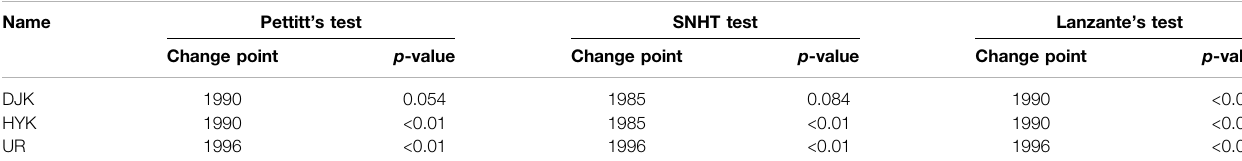
TABLE 3 | Results of Pettitt, SNHT, and Lanzante tests for change point from 1961 to 2018.